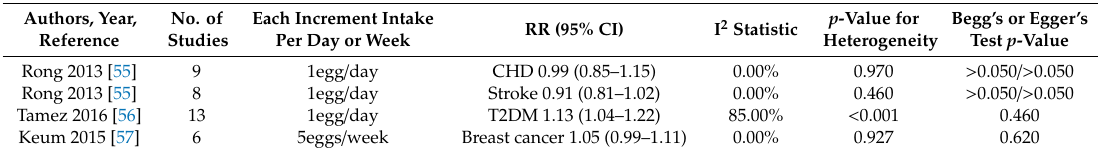
Table 11. Summary of linear dose-response meta-analyses of prospective studies on egg intake and CHD, stroke, T2DM, breast cancer.